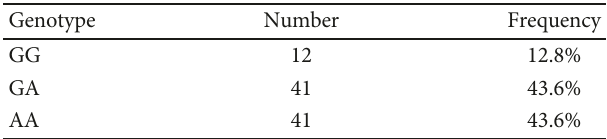
Table 1: STAT3 rs744166 genotyping in a cohort of Crohn ’ s disease